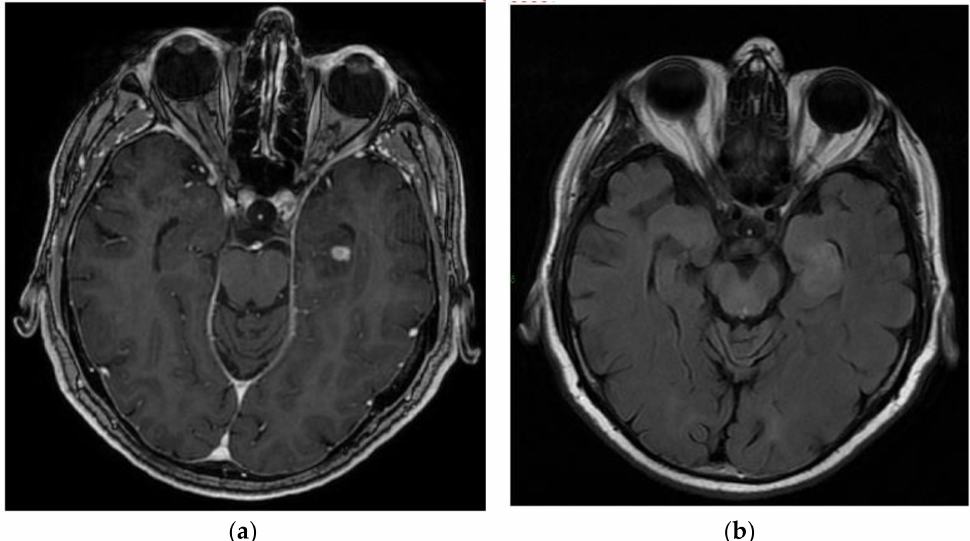
Figure 3. A 72-year-old male with left temporal lobe ganglioglioma. After the diagnostic biopsy, the patient was followed and treated with chemotherapy and radiotherapy at recurrence. ( a ) T1-weighted image after gadolinium infusion; ( b ) Flair-weighted